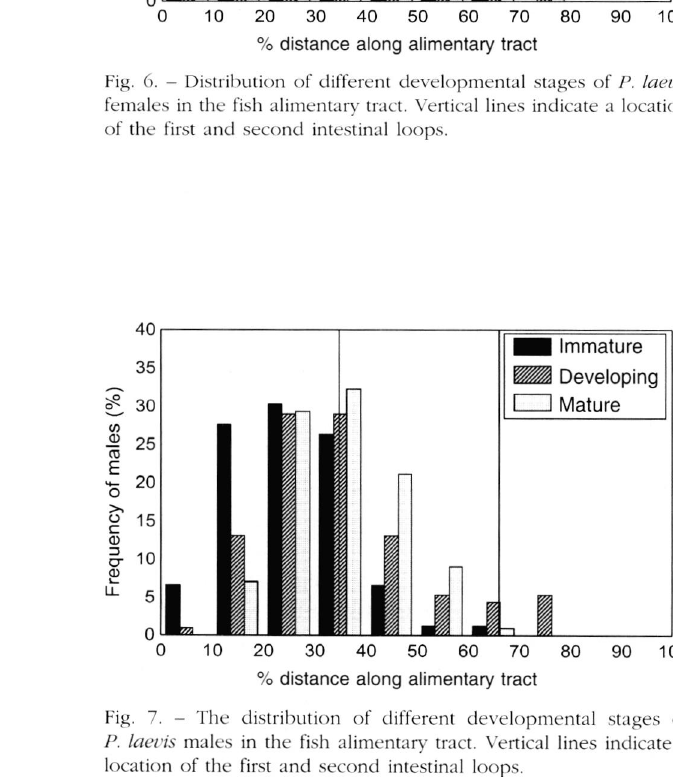
Fig. 7. - The distribution of different developmental stages of P. laevis males in the fish alimentary tract. Vertical lines indicate a location of the first and second intestinal